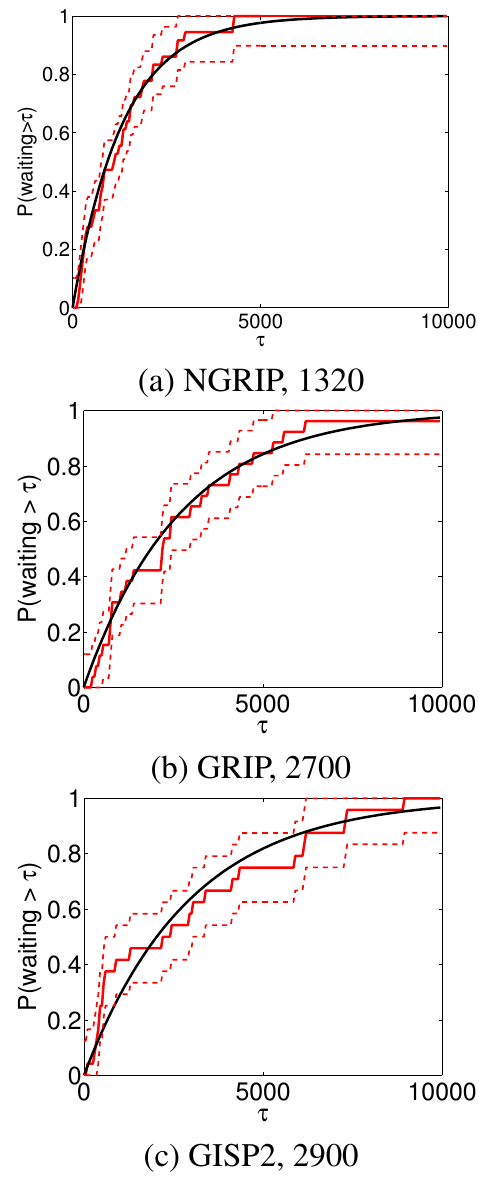
Fig. 5: Empirical cumulative waiting times (red) with the best fit exponential distribution (black) and the 95% confi- dence interval. Also given are the mean waiting times in